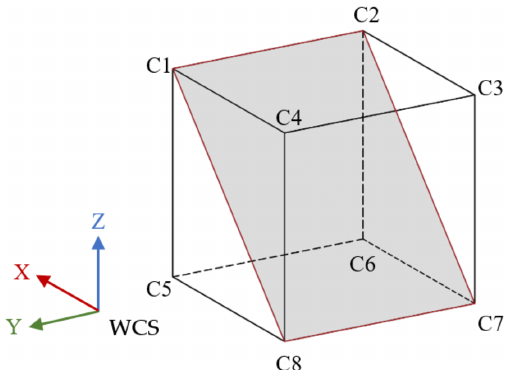
Figure 6. ISO cube with a measuring plane, for robots with six controlled axes.